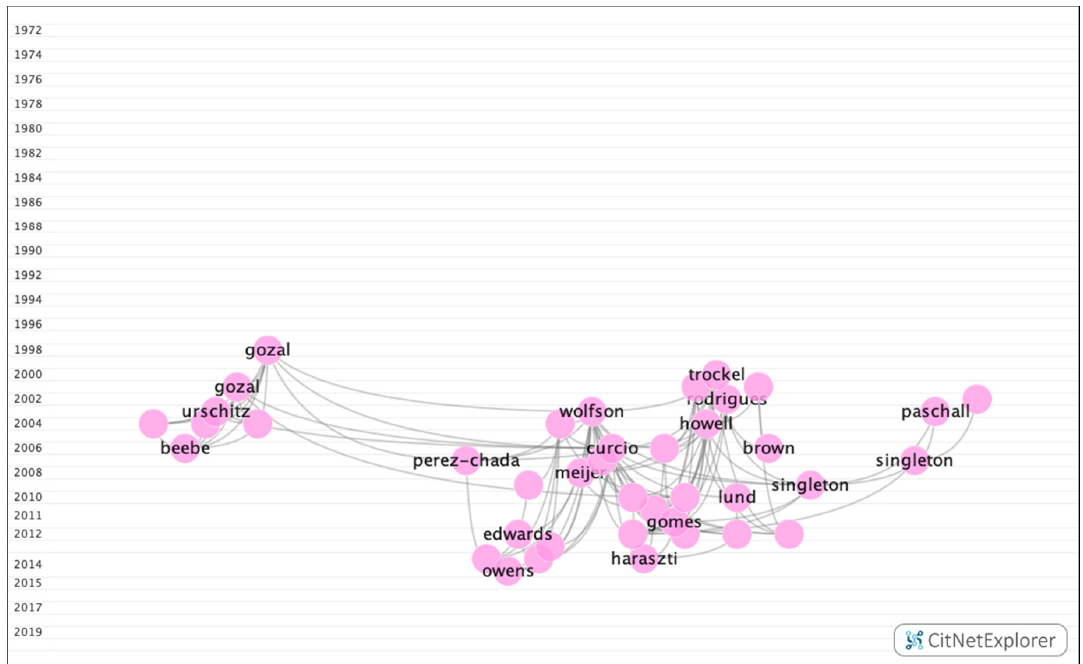
Figure 13. Group 7 citation network.